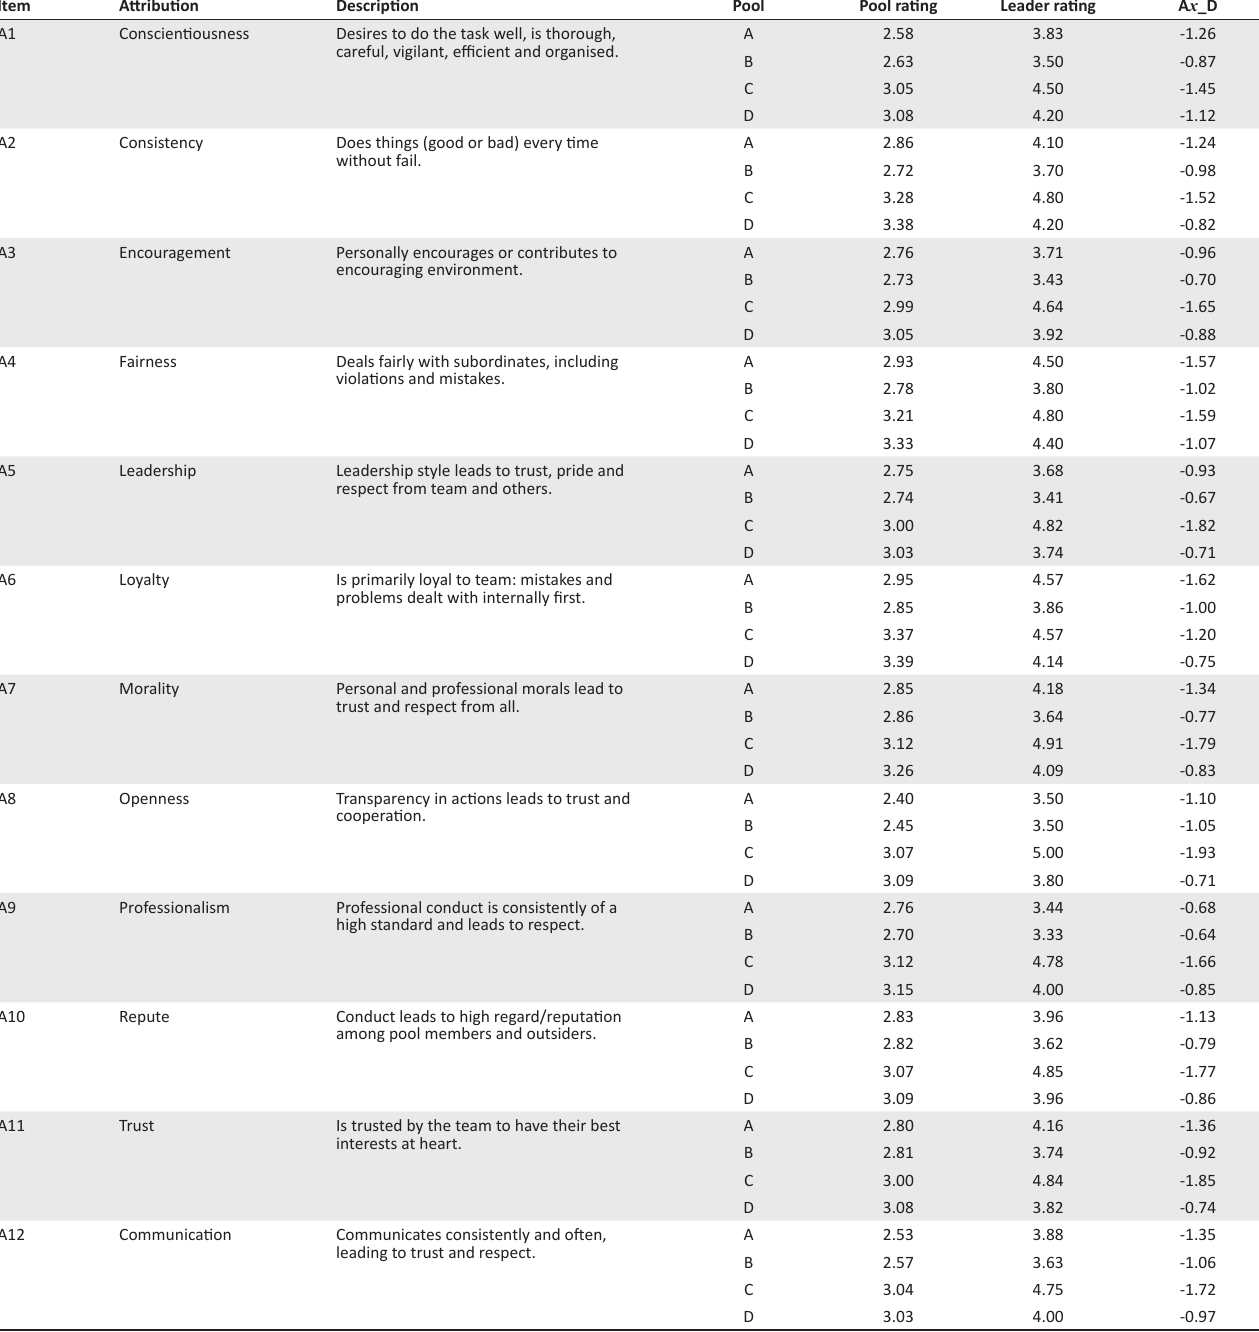
TABLE 4: Leadership Style Inventory attribution criteria and attributional discrepancy (A x _D) values. Item Attribution